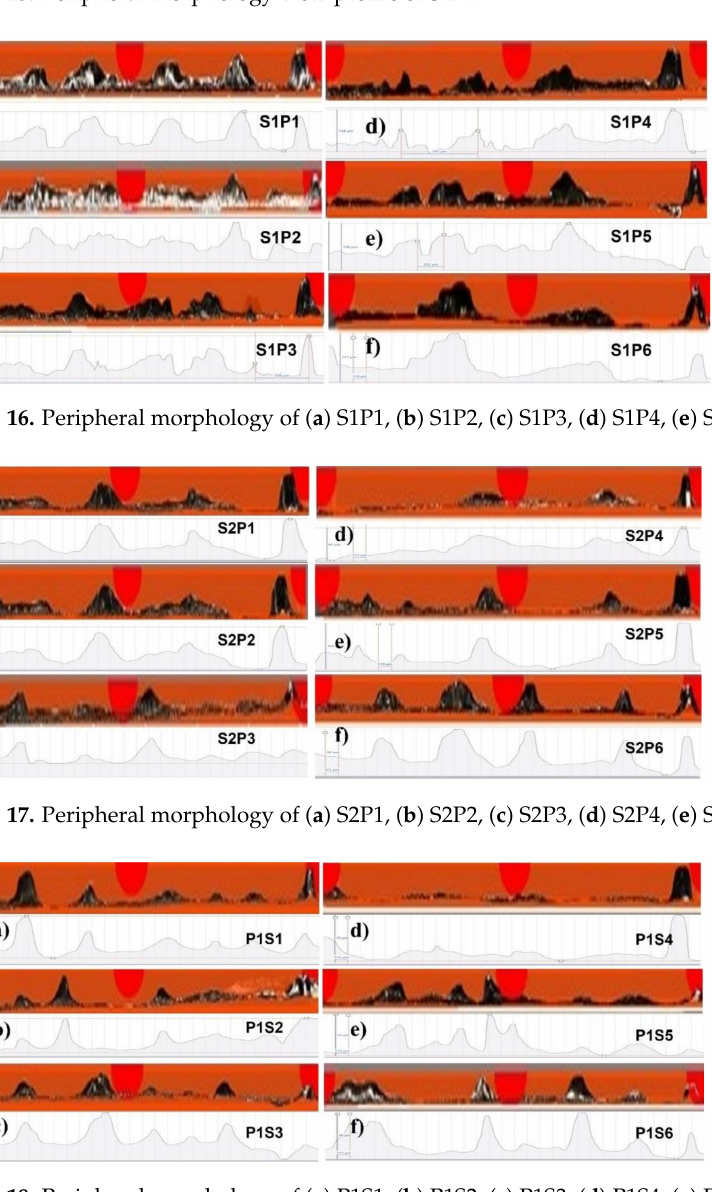
Figure 15. Peripheral morphology view profile of S1P1.